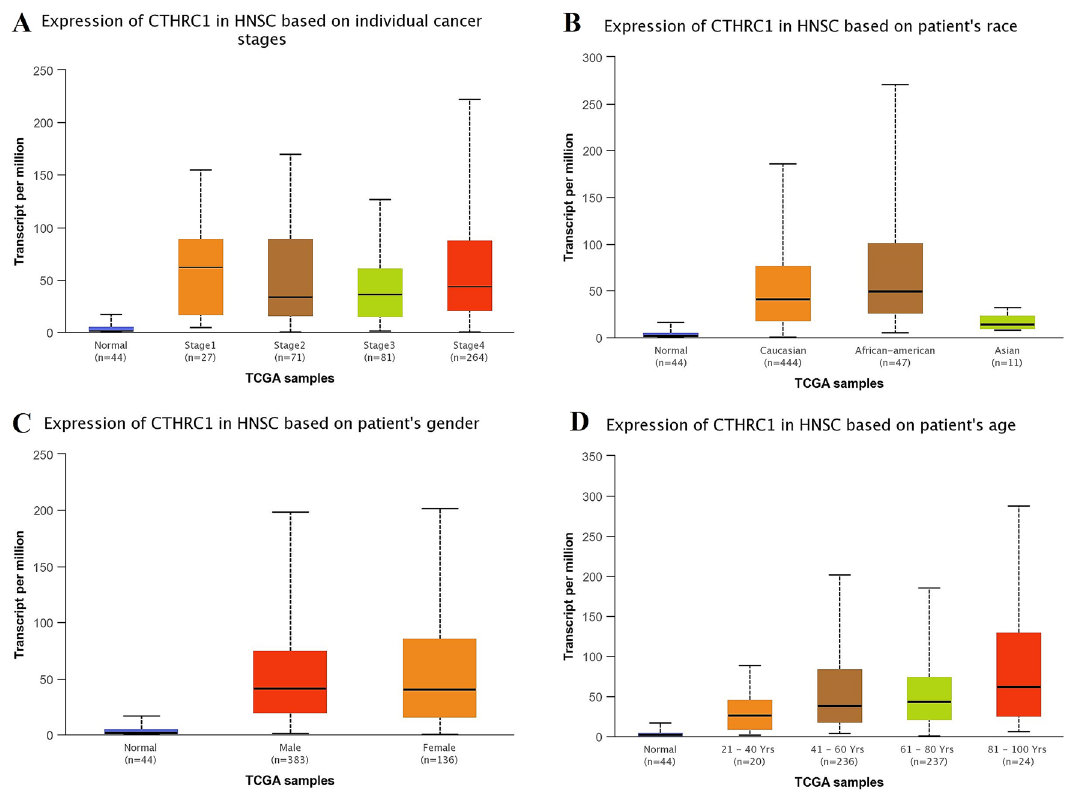
Figure 4. CTHRC1 transcription expression in various clinicopathological parameters of HNSC. ( A ) Different cancer stages based, ( B ) Different patients race based, ( C ) Different patients gender based, and ( D ) Different age groups based. A p-value of < 0.05 was selected as a cutoff